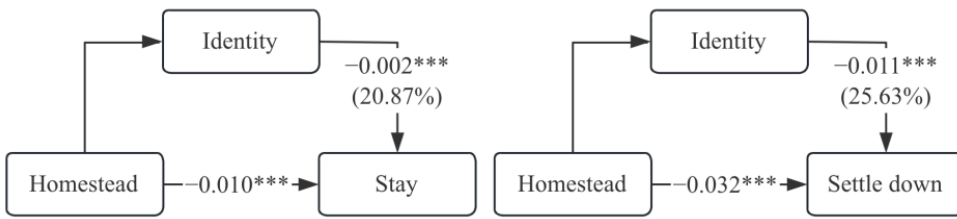
Figure 2. Mediating relationship. *** p < 0.01, ** p < 0.05, * p < 0.1.